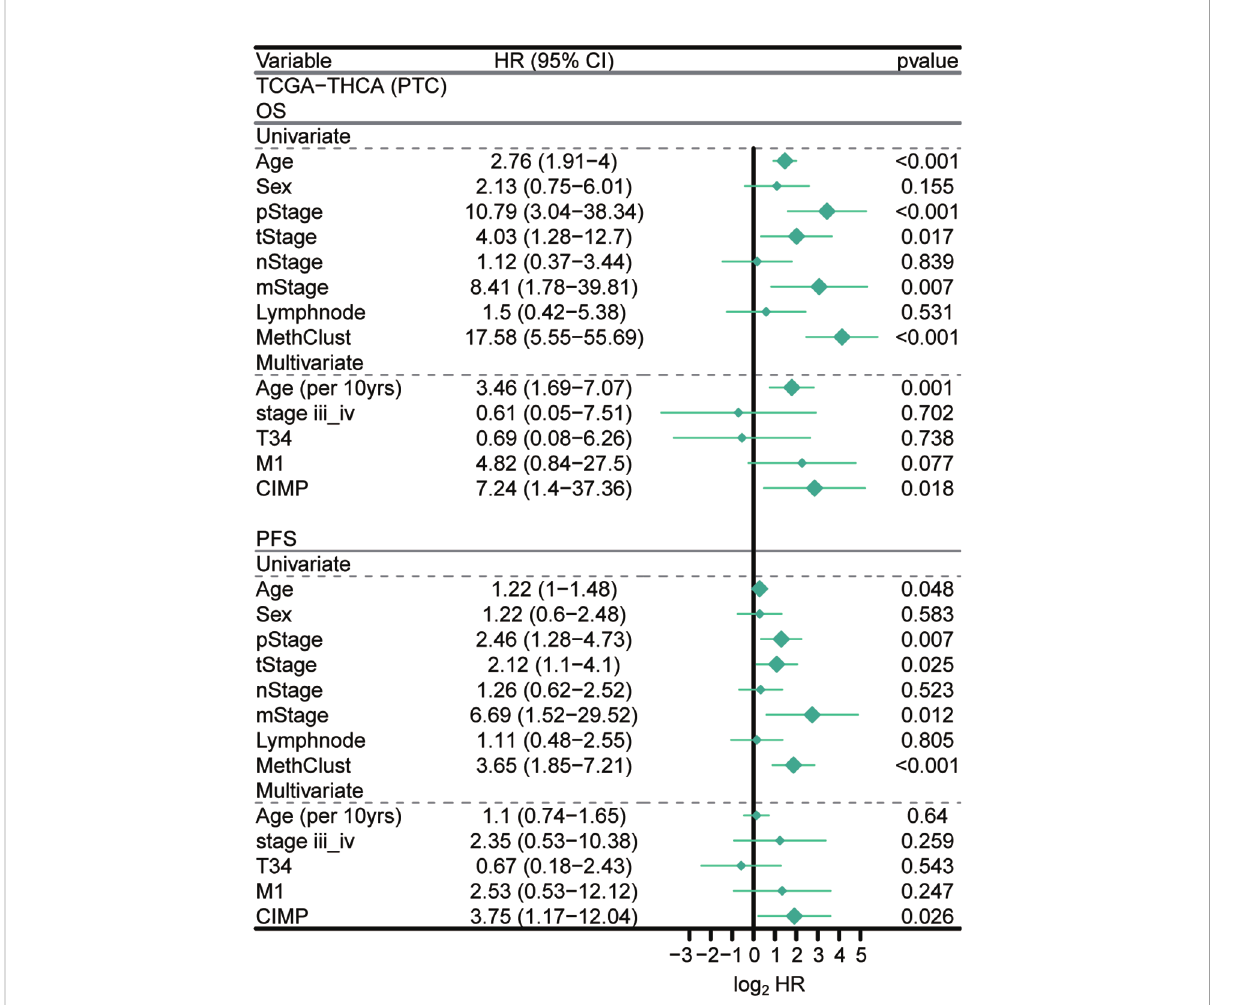
FIGURE 6 Independent prognostic value of CIMP. Forest plot showing the hazard ratio (95% CI) in univariate and multivariate Cox regressions with the corresponding P